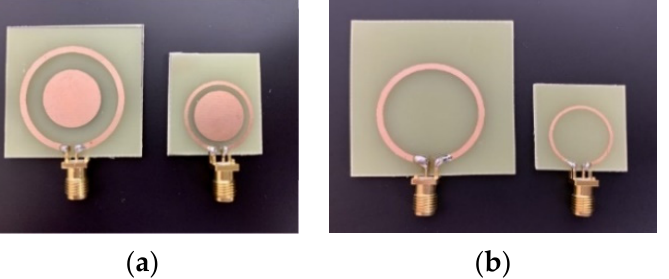
Figure 3. Photographs of the ( a ) tuned resonate couplers with a center pad and ( b ) single loops without the pad.